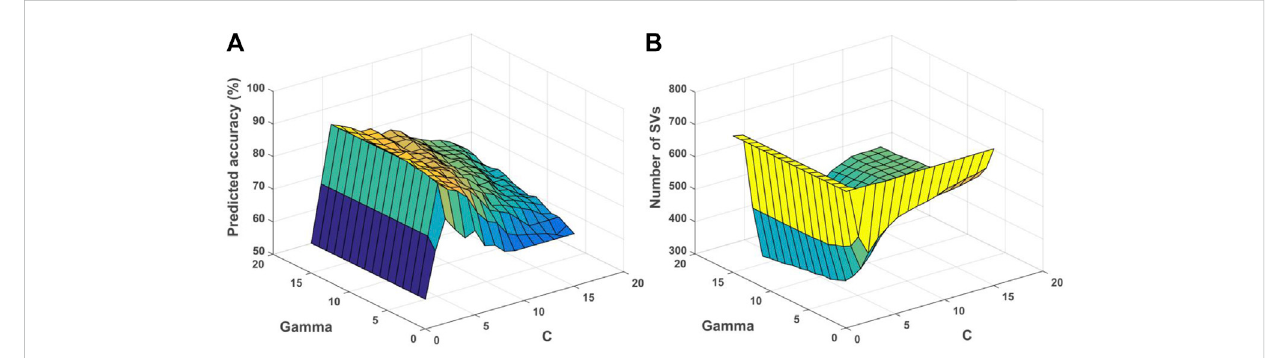
FIGURE 7 Relationship among parameters, predicted accuracy and support vectors for the depression prediction. (A) Relationship among gamma , C and predicted accuracy. (B) Relationship among gamma , C and number of SVs. SVs, support